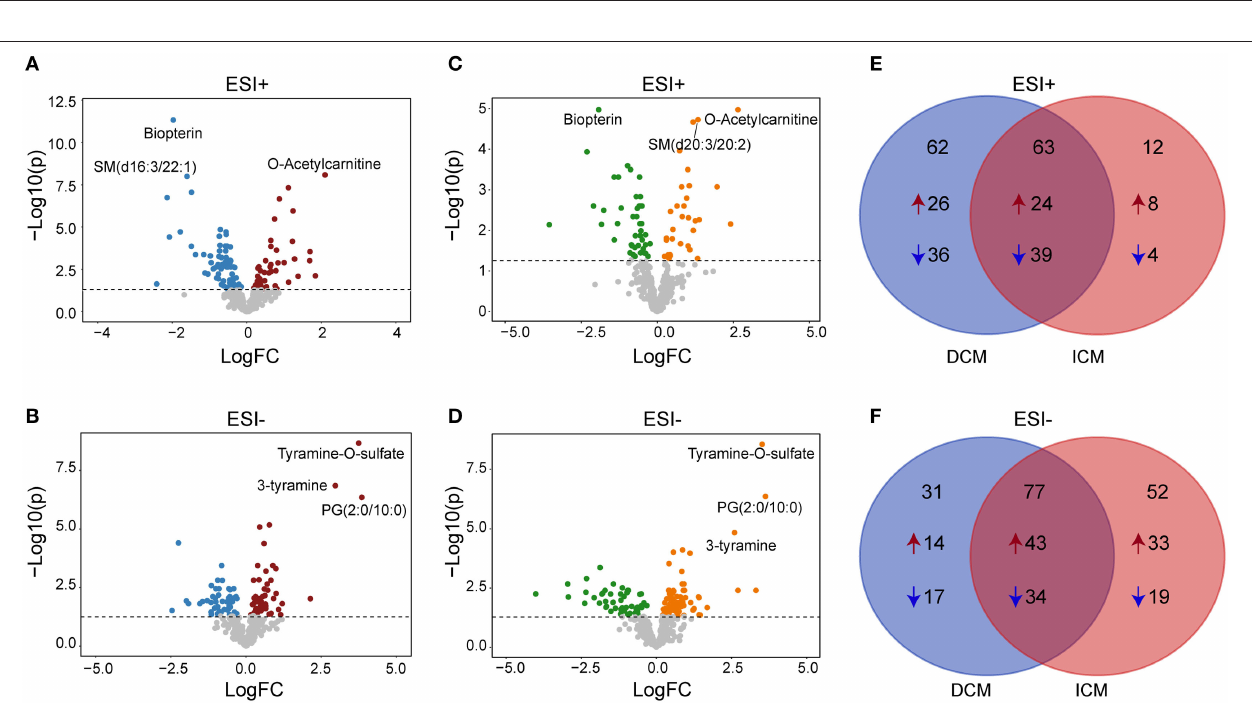
FIGURE 2 | Score plots of PLSDA model in positive and negative ion modes. In the three-dimensional score plots, each plot represents a sample. They showed a distinct classification in healthy controls (gray) and patients with DCM (blue) and ICM (red) in positive ion mode (A) and negative ion mode (B) .